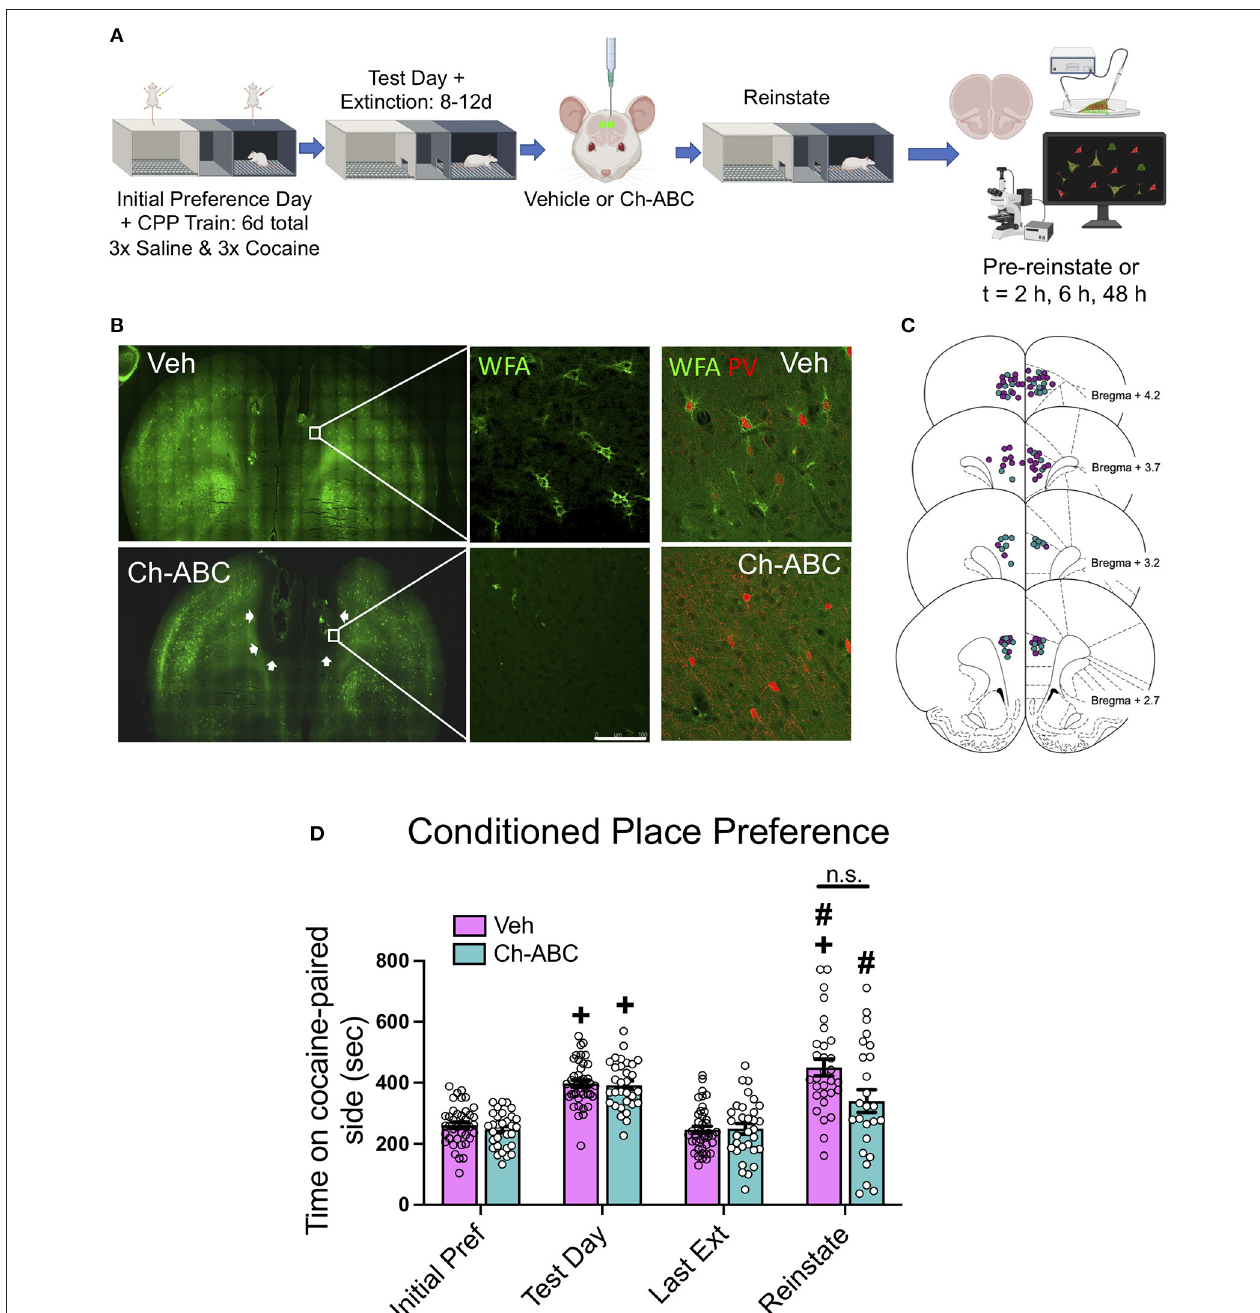
FIGURE 1 | PNN removal in the mPFC has minimal impact on cocaine-primed reinstatement. (A) Experimental timeline for cocaine-induced CPP training, testing, and reinstatement. (B) (Top panels) Representative images of WFA-stained coronal sections of mPFC of vehicle and Ch-ABC-treated rat. White line = 100 µ m. Upper right panel: WFA/PV double-labeled cells in vehicle-treated rat; Lower right panel: WFA/PV double-labeled cells in Ch-ABC-treated rat; note lack of WFA surrounding PV cells. (C) Schematic diagram (Paxinos and Watson, 2007) of mPFC coronal rat brain sections depicting stereotaxic coordinates of vehicle and Ch-ABC microinjections; purple, vehicle; teal, Ch-ABC. (D) There were no differences in treatment within subjects on initial preference (Initial Pref) or test day. Both treatment groups showed cocaine CPP on test day compared to their initial preference day within subjects. Both treatment groups also showed cocaine-induced reinstatement compared to their last extinction day (Last Ext). Vehicle subjects showed increased preference on reinstatement day (Reinstate) compared to their initial preference day. Data are mean ± SEM. For vehicle, n = 40; Ch-ABC n = 31 rats. + P < 0.05 compared with initial preference day; # P < 0.05, compared with last extinction day. Created with